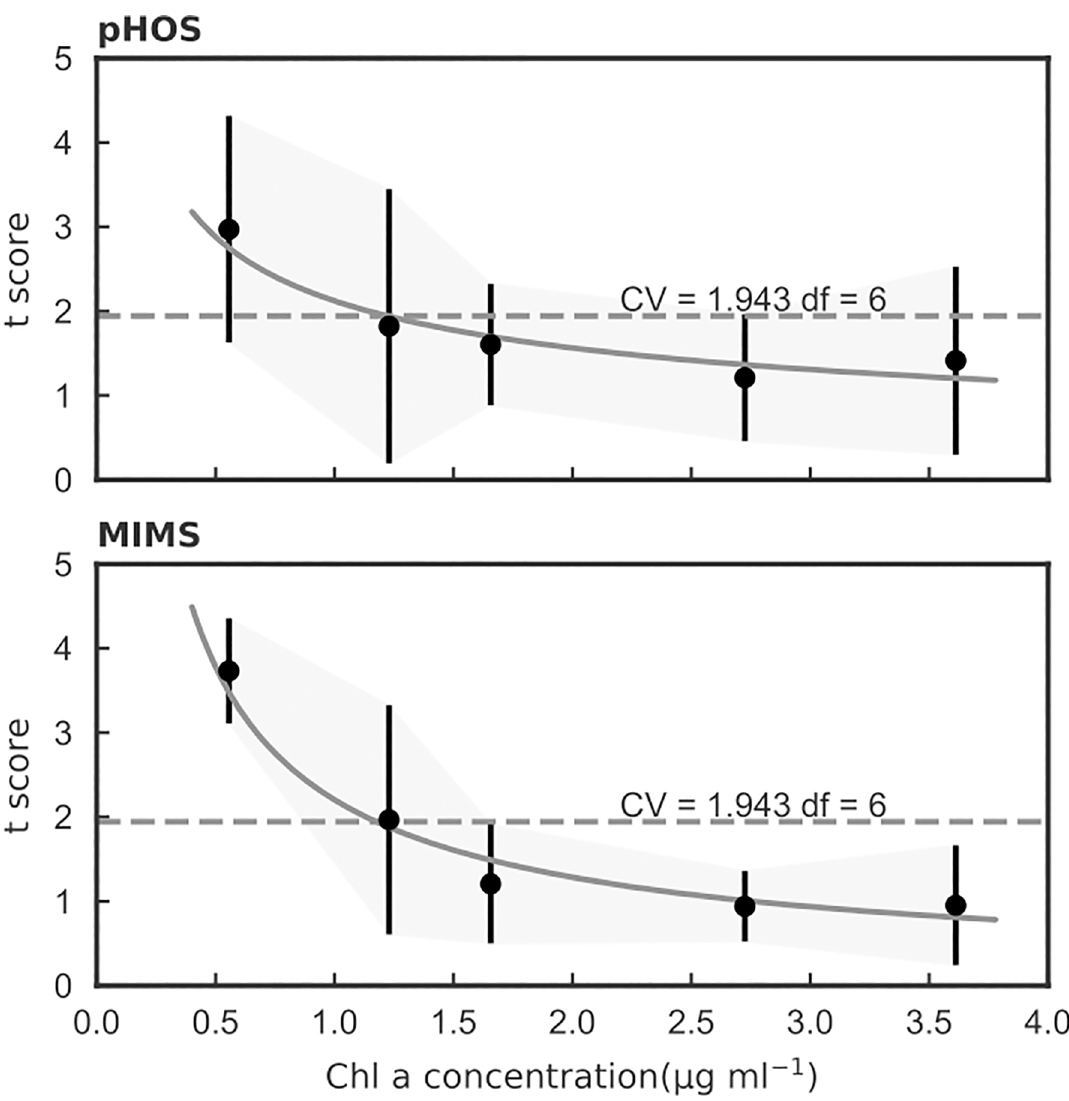
Fig 3. t-scores of pHOS and MIMS measurements as a function of Chla concentration. The critical value (CV = 1.943) for 95% confidence in replicates is marked with a dashed line. For Chla > 1.5 μ g mL -1 replicated measurements are not significantly different.